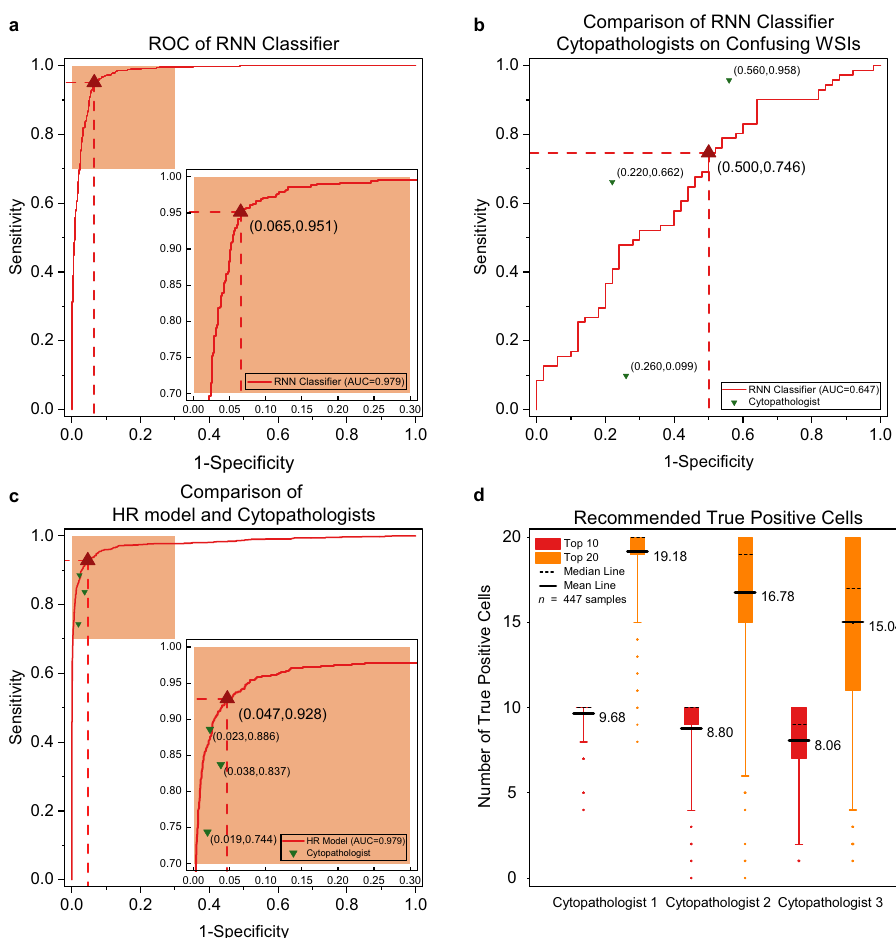
Fig. 3 Clinical-level experimental results. a The ROC of the RNN model for classifying the slides of groups E and F ( n = 1,170). b Comparison of the RNN model and three cytopathologists at the slide level ( n = 121). The most confusing 121 slides of the 1,170 slides were classi fi ed by the RNN model and the three cytopathologists. Each green triangle refers to 1-speci fi city and sensitivity of a cytopathologist ’ s result. c Comparison of the HR model and the three cytopathologists at the tile level. Randomly selected 1018 positive test tiles and 3,047 negative test tiles with a size of 256 × 256 (0.243 μ m/pixel) from groups E and F ( n = 4,065 tiles) were simultaneously classi fi ed by the HR model and three cytopathologists. d The average true positive numbers of the recommended top 10 and top 20 lesion cells on positive slides in groups E and F ( n = 447), evaluated by three cytopathologists separately. The boxes indicate the upper and lower quartile values, the whiskers indicate the 95% and 5% quantile values, the middle bold solid line and dotted lines indicate the mean and median values, and the scatter dots indicates